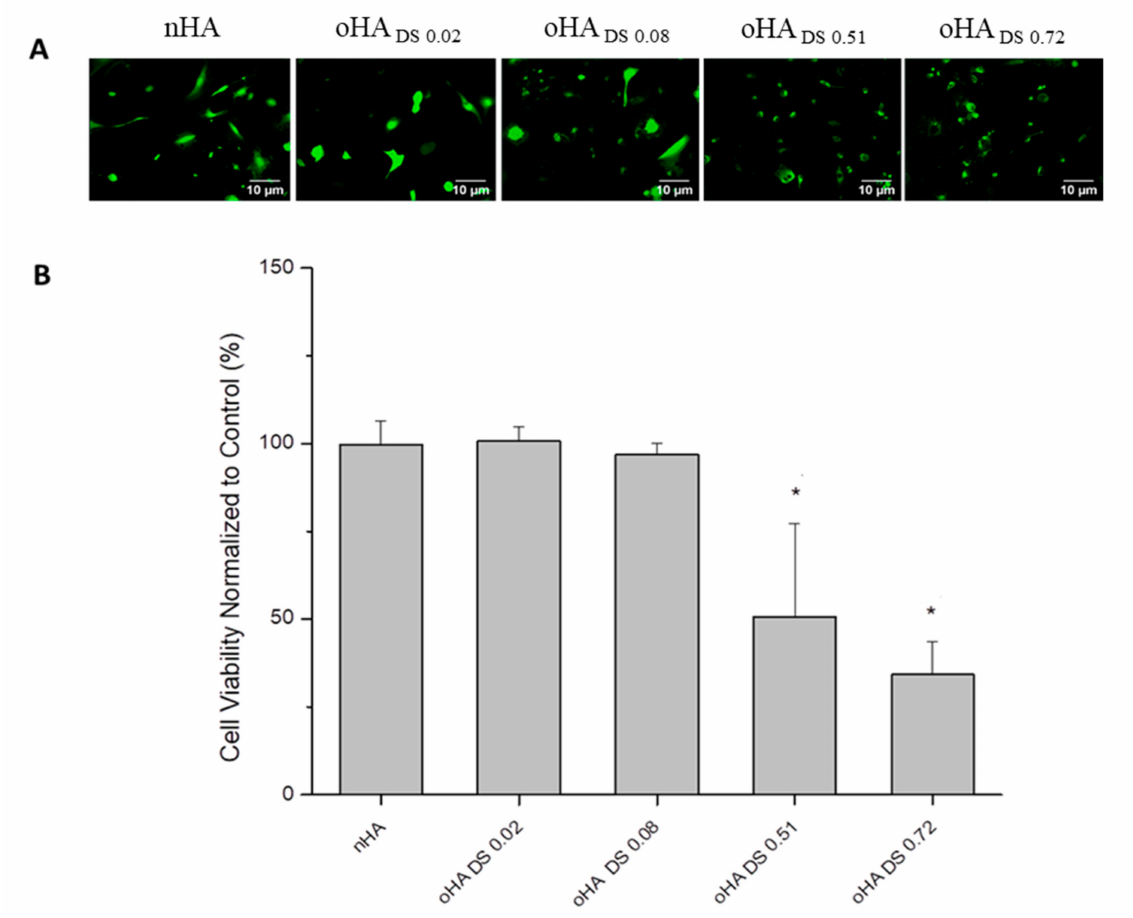
Figure 5. ( A ) Fluorescence micrographs after staining with vital stain CFDA and ( B ) viability studies by Q-blue assay of 3T3-L1 fibroblasts incubated in native and oxidized hyaluronic acid solutions in PBS with a concentration of 5 g L − 1 for 24 h; scale bar: 10 µ m. Data represent mean ± SD values normalized to control, n = 10, * p ≤ 0.05; compared to native hyaluronic acid